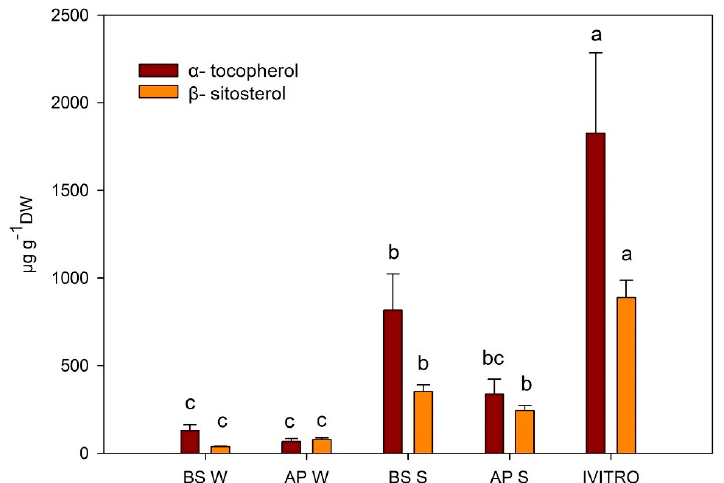
Figure 6. Yield ( µ g g − 1 DW) of α -tocopherol and β -sitosterol from A. chilensis leaves. Median ± E.E. (one-way ANOVA, Tukey, p ≤ 0.05, n = 3). Different letters in the same row indicate significant differences according to Tukey´s test. BS W: Basal winter leaves, AP W: apical winter leaves, BS S: basal spring leaves, AP S: apical spring leaves, and IVITRO: in vitro leaves.